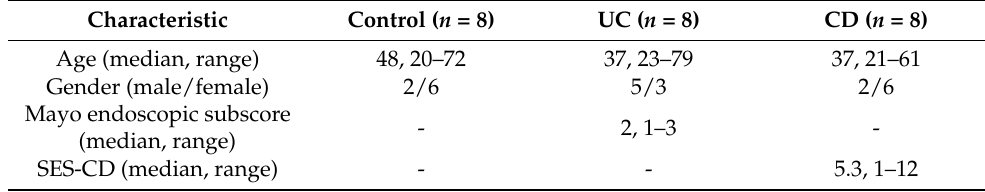
Table 1. Characteristics of the enrolled patients.